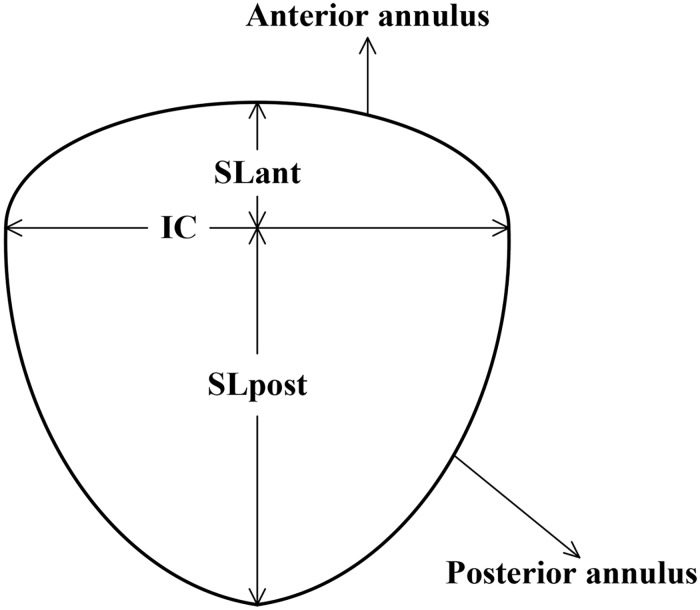
The mitral annulus.The inter-commissural axis IC = 2.8 cm, The septolateral of the anterior SLant is equal to 1.04 cm and the septolateral of the posterior SLpost is equal to 2.11 cm.